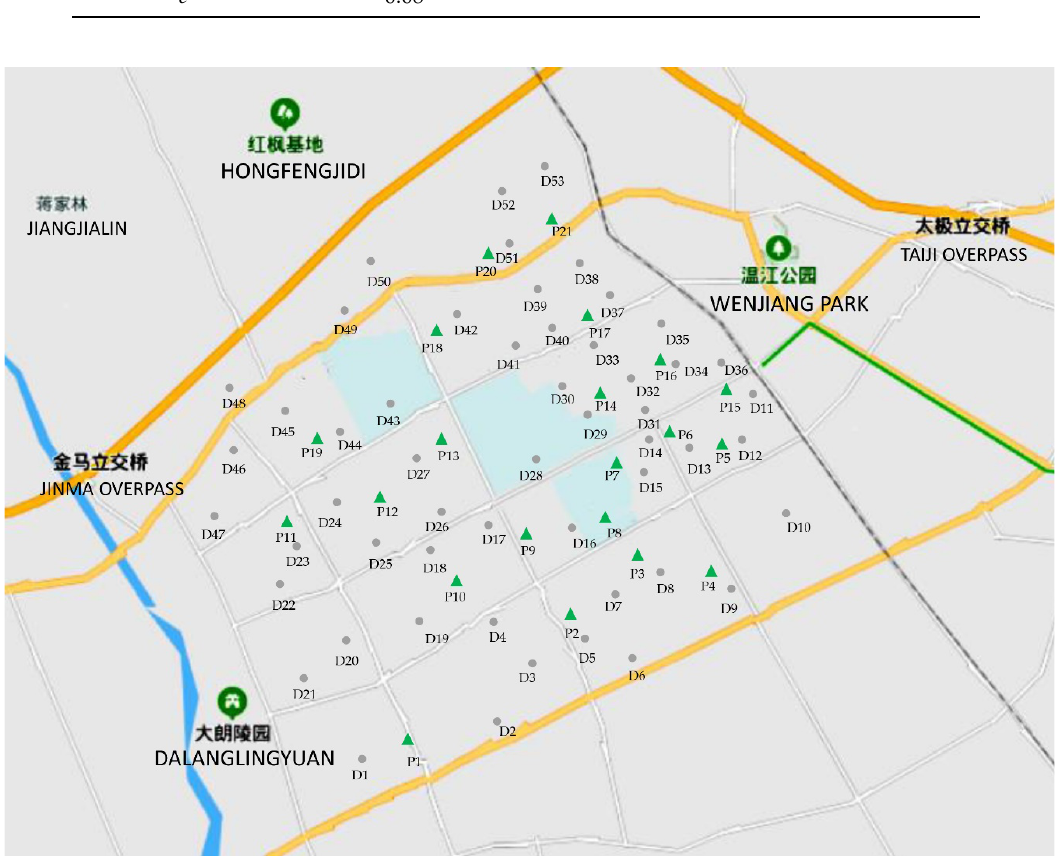
Figure 3. The urban area map of Wenjiang, Chengdu, China.